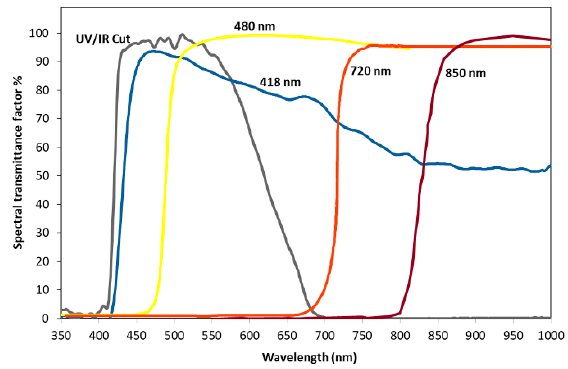
Figure 1. Spectral transmittance factors of the optical filters used to remove the excitation wavelengths from the acquired images.